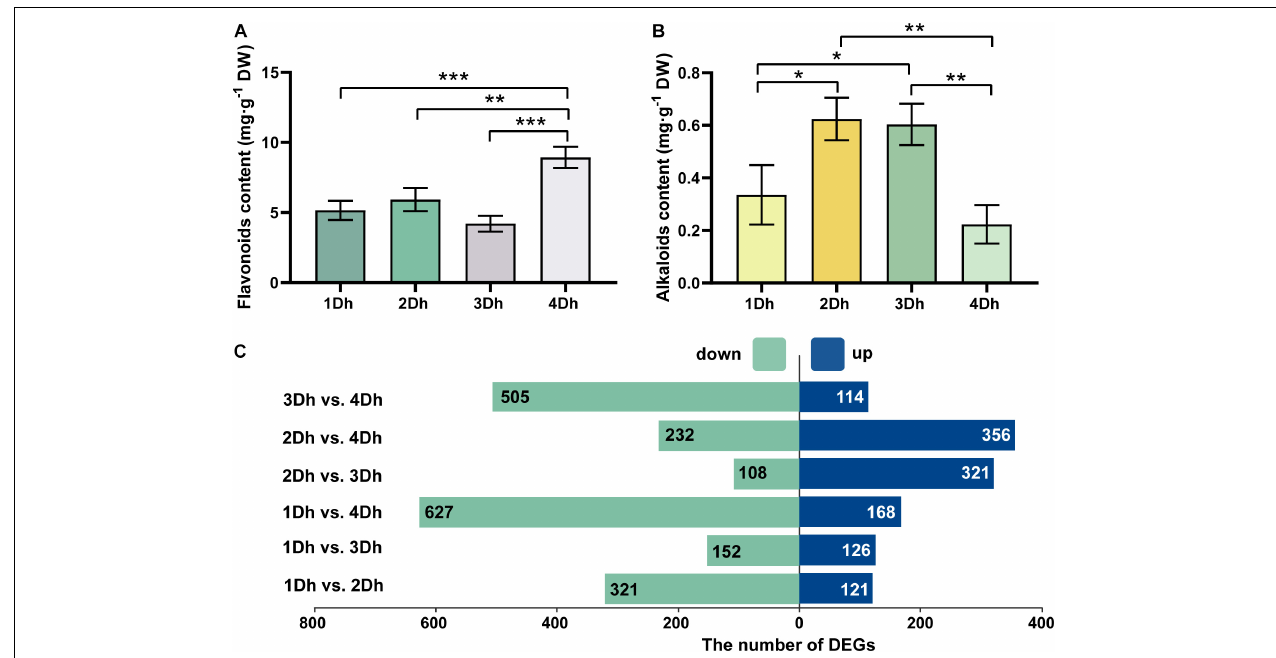
FIGURE 1 | Determination of total flavonoids and alkaloids in the stem of D. huoshanense and DEGs in different comparison groups. Error bars represent standard deviations. Asterisks “*” mean statistical differences of the same index between different growth years, and p < 0.05 is a significant difference (* p < 0.05, ** p < 0.01, and *** p < 0.001). (A) Content of total flavonoids in stems of D. huoshanense with different growth years. (B) Contents of total alkaloids in stems of D. huoshanense with different growth years. (C) The number of DEGs in different comparison